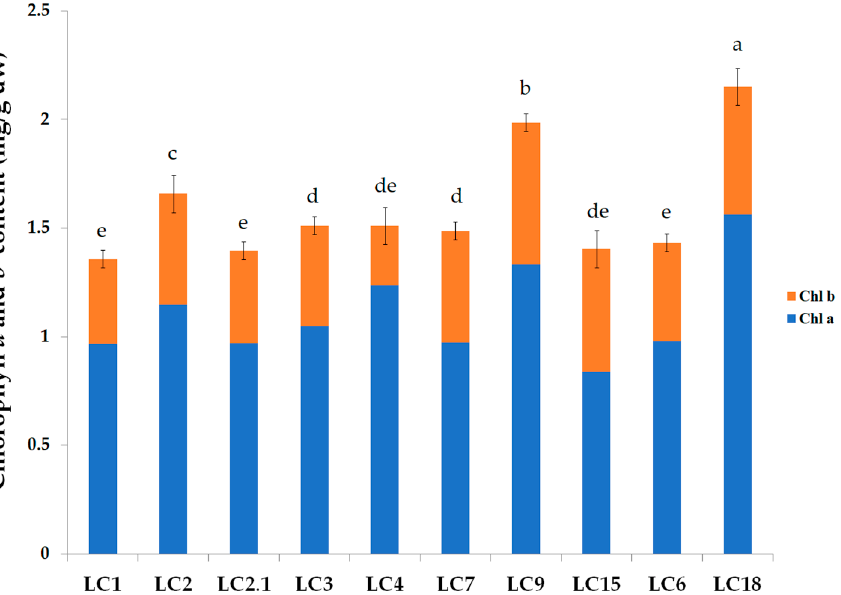
Figure 2. Chlorophyll a and b content in Cyclamen leaves. Different letters indicate significant dif- ferences ( p <